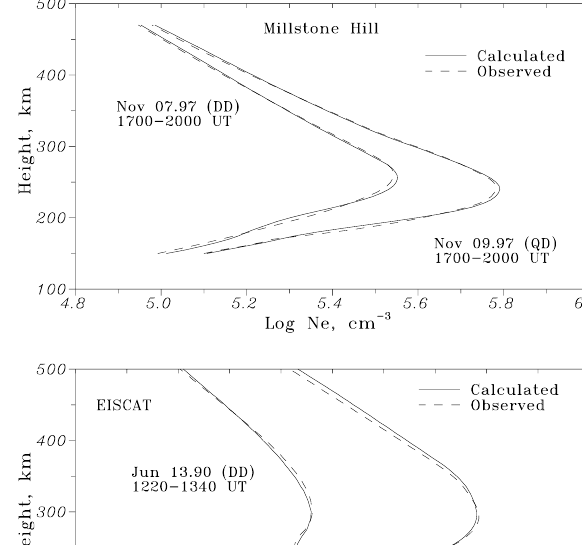
tion ( O + /Ne ratio) was strongly different from the model one used in the incoherent scatter data analysis